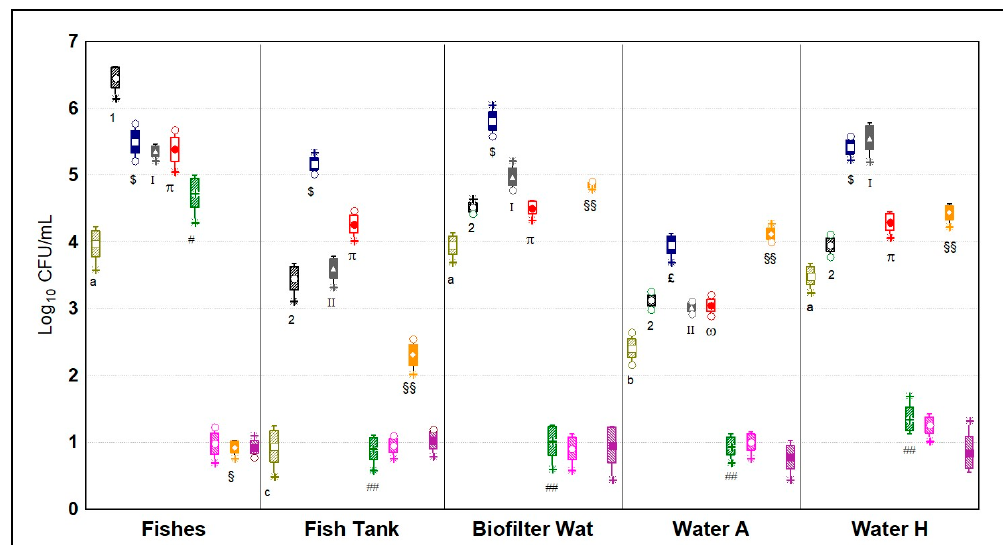
Figure 7. Microbial quantifications in Log 10 CFU/mL ( n = 4) of the nine different microbial targets; olive green = coliforms; black stripes = Enterobacteriaceae ; blue = aerobic mesophilic bacteria; gray = anaerobic mesophilic bacteria; red = psychrotrophic bacteria; green = lactic acid bacteria; fuchsia = yeasts and molds; orange = Pseudomonas spp . ; violet = enterococci; Fishes = Fillets of Nile tilapia; Fish tank = water samples from tank for fishes; Biofilter Wat = water samples from the biofilter; Water A = water samples from tank of aquaponic cultivation; Water H = water samples from tank of hydroponic cultivation. Different letters, numbers, Latin numbers, Greek letters, or symbols indicate statistical significance among a microbial target by Tukey’s HSD test ( p < 0.05). Samples were analyzed in duplicate from two independent experiments ( n = 4). Box = mean; rectangles = mean*S.D.; whiskers = min and max values; asterisks = extremes; dots = outliers.